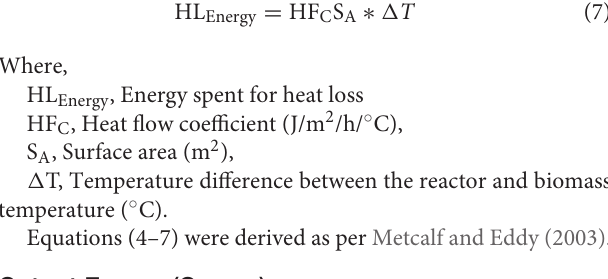
mg/L) was achieved within the pretreatment time of 30